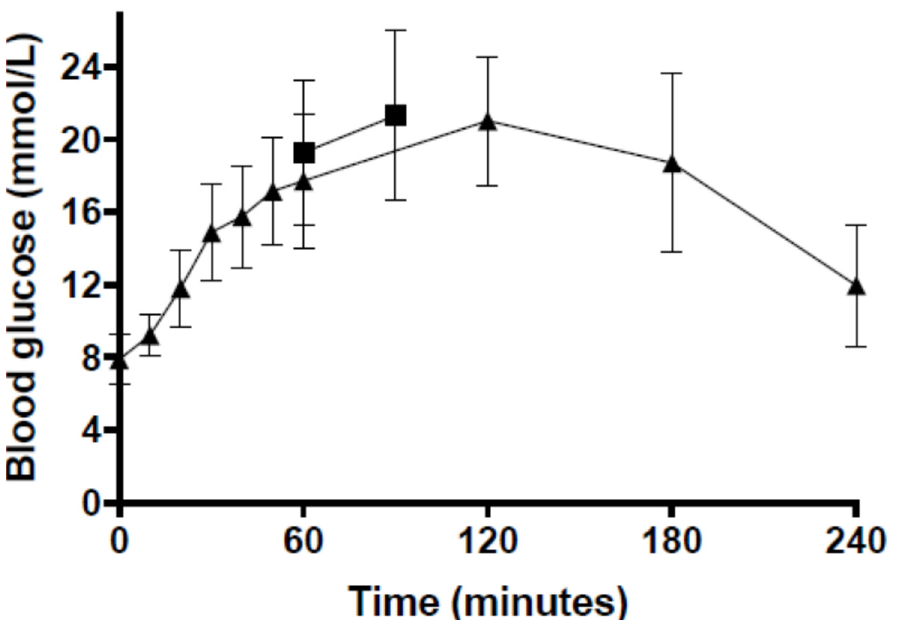
Figure 1. Time course of mean (±standard deviation) blood glucose concentration during anaesthesia of Sprague-Dawley rats in Group T (0.05 mg/kg medetomidine subcutaneous (SC) followed by a continuous infusion of 0.15 mg/kg/h SC with 0.5% isoflurane; squares) and Group SC (0.05 mg/kg medetomidine SC; triangles).